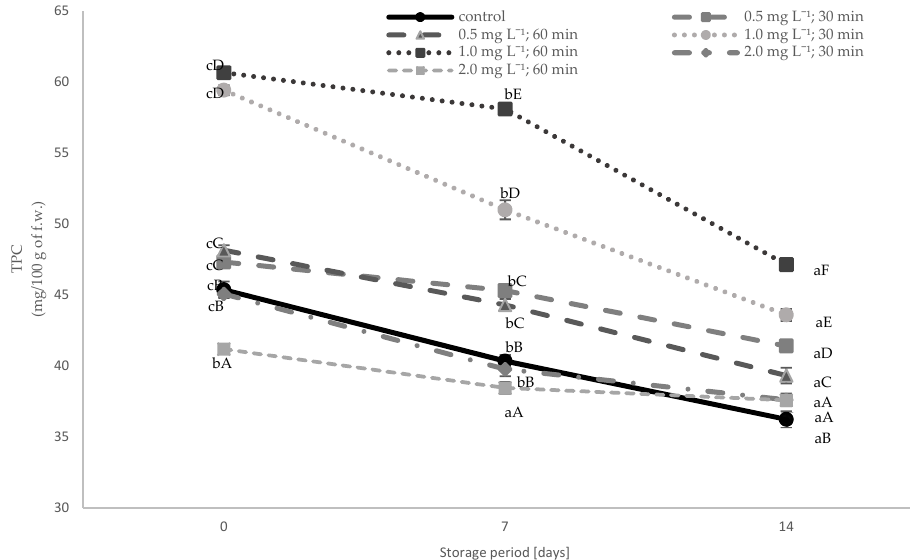
Figure 1. Effect of ozone dose, time of ozonization, and storage time on total phenolic content of Agaricus bisporus measured on 0, 7, and 14 days of storage at 2 ◦ C. a–c: significant statistical differences for each treatment during storage time ( p < 0.05); A–F: significant statistical differences between treatments within each storage time ( p < 0.05). The values represent the mean ± standard error.